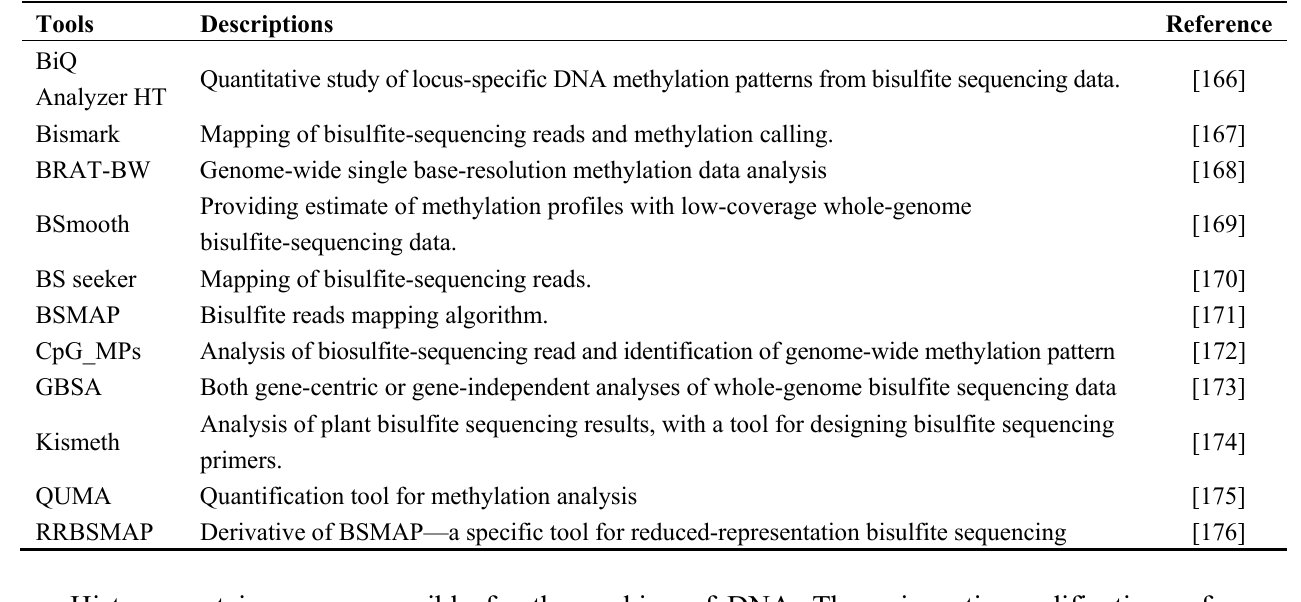
Table 7. Bioinformatics tools for the analysis of bisulfite sequencing